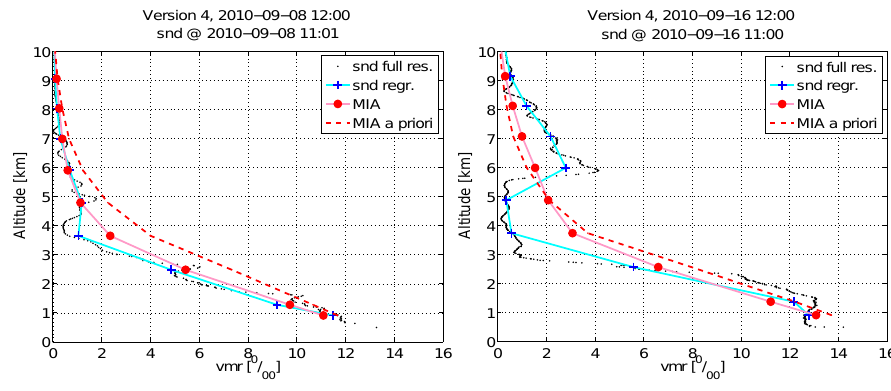
Fig. 15. Two examples of retrieved H 2 O vmr profiles from 2h averaged spectra (MIA) against profiles from balloon soundings in Payerne (snd). The soundings are plotted in full resolution (snd full res.) and regridded to the retrieval grid using the Curtis-Godson approach (snd regr.). Further plotted are the a-priori profiles (MIA a priori). The left plot (8 September 2010) shows a situation of good congruence. On the right plot (16 September 2010), the balloon sonde detects a very dry layer between 3 and 6km. The retrieval, not able to resolve this feature, makes a strong smoothing between the dry layer and above, which leads to far too high values below 6km and too low values above.